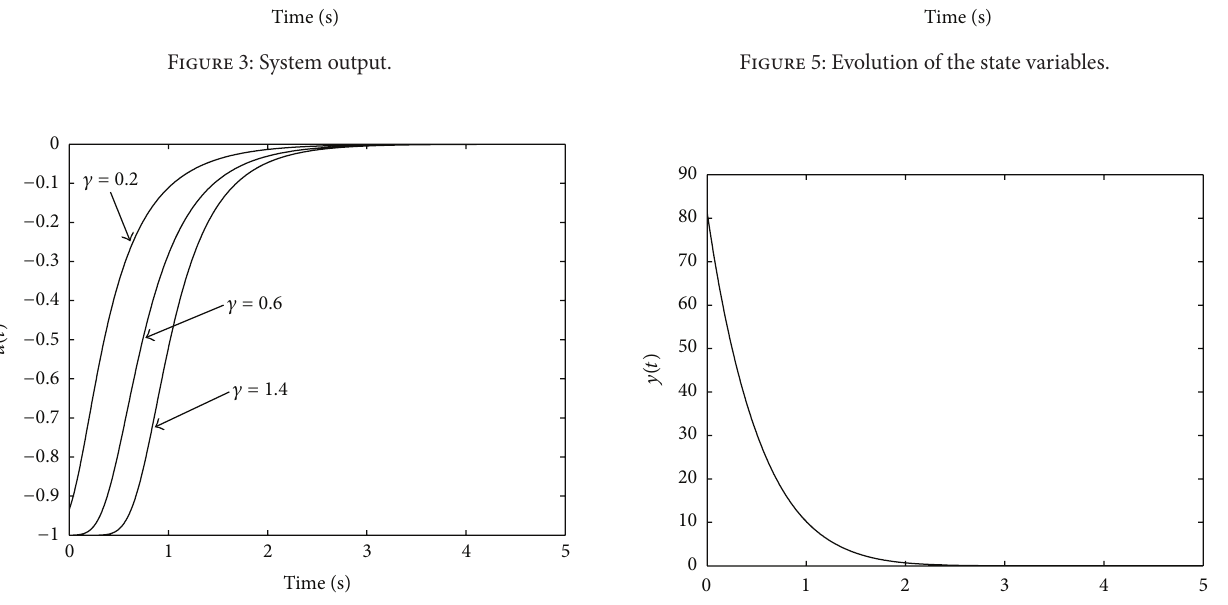
Figure 4: Control input 𝑢(𝑡) = −𝜑(𝑦,𝑡) .